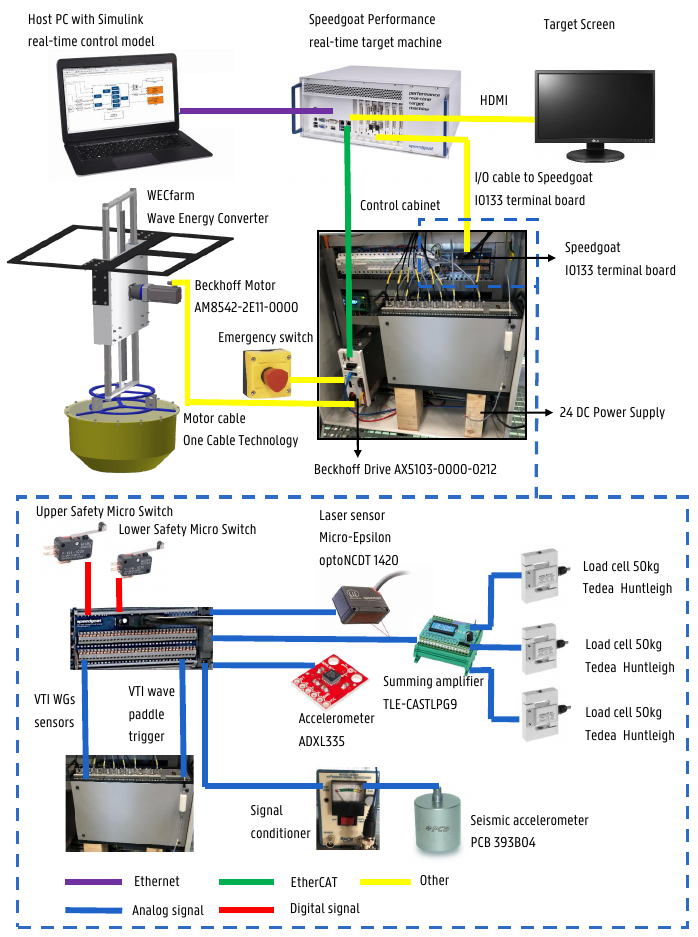
Figure 3. General data acquisition and control flow for the isolated ‘WECfarm’